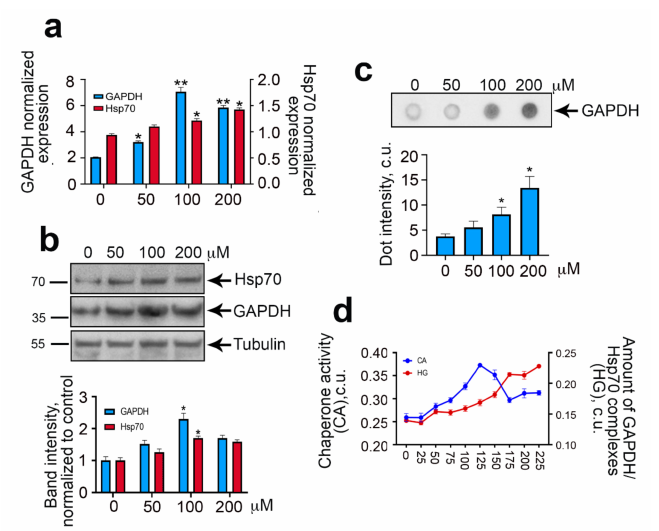
Figure 2. CoCl 2 induces GAPDH expression and aggregation in C6 cells. ( a ) The data of RT-PCR are presented. Histogram bars show the relative normalized expression of gapdh and hsp70 genes in C6 cells 6 h after addition of CoCl 2 . Actin was used as a reference gene. ( b ) Immunoblotting data are presented in the upper panel. C6 cells were treated with CoCl 2 in the concentrations indicated. Cells were analyzed 24 h after addition of CoCl 2 . Tubulin is presented as a loading control. The data of immunoblotting quantification are presented in the lower panel. Histogram bars show the relative intensity of GAPDH and Hsp70 bands to intensity of tubulin bands normalized to this meaning for naïve cells. ( c ) C6 cells were incubated with CoCl 2 for 24 h, then lysed and subjected to dot ultrafiltration, and the membrane was probed with anti-GAPDH antibodies (upper panel); dot intensity is presented in the lower panel. ( d ) C6 cells were incubated with CoCl 2 for 24 h, then lysed. The Hsp70 chaperone activity and number of Hsp70–GAPDH complexes were measured in cell lysates with the aid of a protein–protein interaction assay. Data presented as mean ± standard error of mean (SEM). Statistical significance is indicated as * p < 0.05 and ** p <